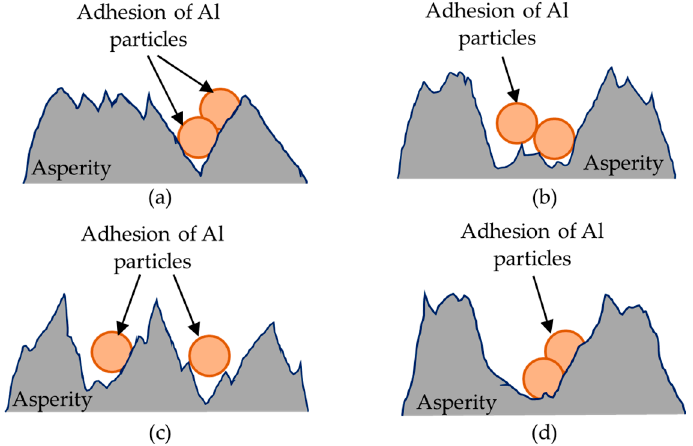
Figure 2. Schematic illustrations of expected surface topographies following the adhesion of parti- cles on machined surface during WEDM: ( a ) negative skewness; ( b ) positive skewness; ( c ) high kurtosis; ( d ) low kurtosis.